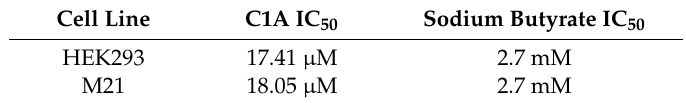
Figure 1. Cytotoxicity of C1A and sodium butyrate on cancerous M21 ( a , b ) and non-tumorigenic HEK293 ( c , d ) cells. Both cell lines were cultured in 96 well plates and treated with increasing concentrations of either C1A ( a , c ) or sodium butyrate ( b , d ). Cell viability percentages are relative to parallel control untreated cell cultures. The assay was repeated twice, in triplicates. Table 1. Median lethal concentration of C1A and sodium butyrate after 24 h of